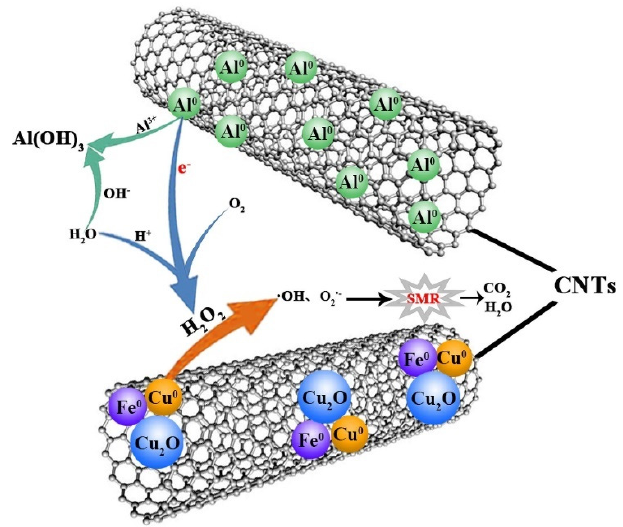
Figure 5. Reaction mechanism of the Al0-CNTs / CNTs-Fe–Cu system for the generation of ROS in the presence of O 2 . Reprinted from Liu et al. [105] with permission from Elsevier.